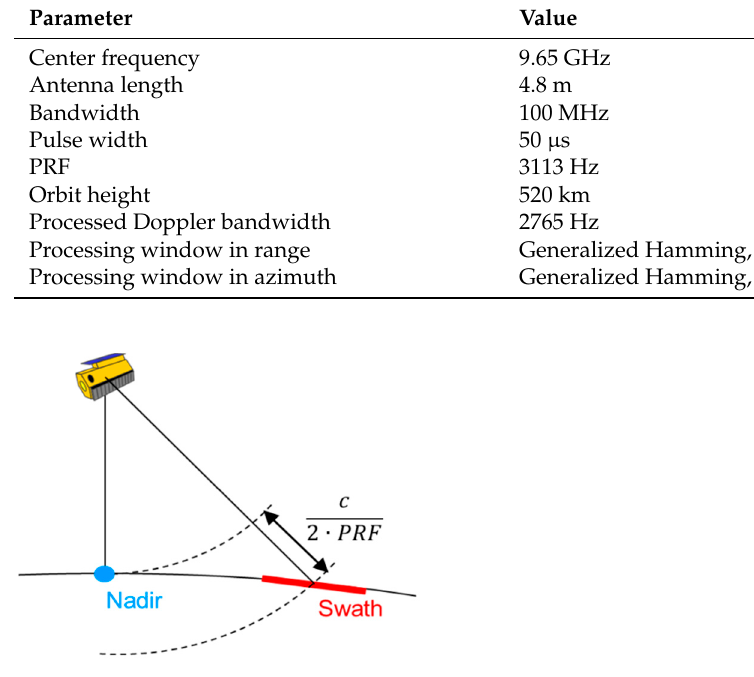
Table 1. System and Processing